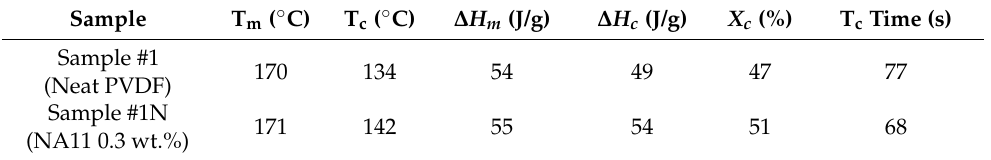
Table 3. Thermal properties of PVDF membranes with and without the nucleating agent.